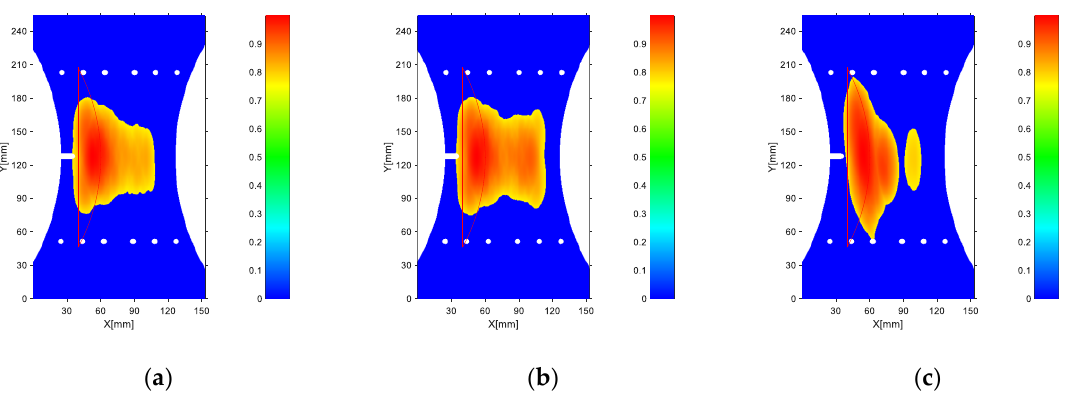
Figure 24. Thresholded imaging with different damage factors at a signal-to-noise ratio of 0.1 dB: ( a ) energy damage factor; ( b ) cross-correlation damage factor; ( c ) sparse representation damage factor.